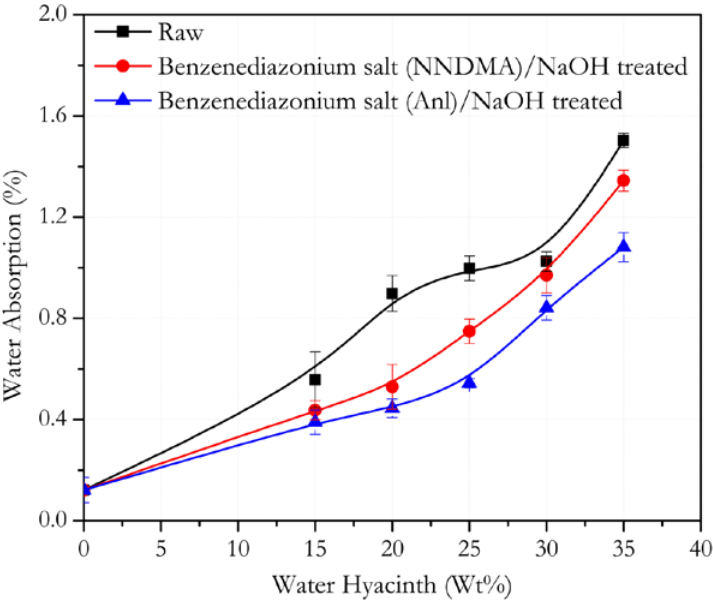
Figure 8: Water absorption characteristics of WH-PP